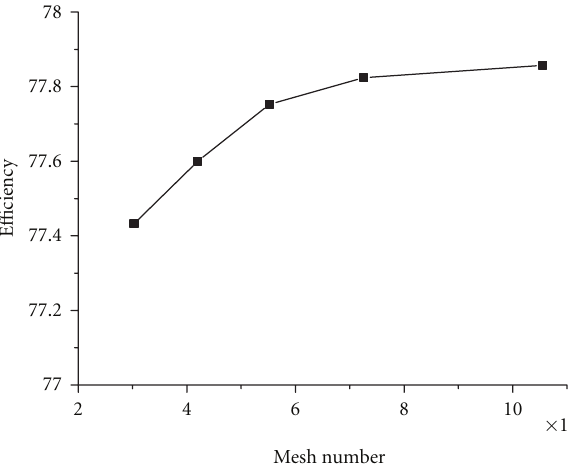
Figure 2: E ffi ciency versus mesh number